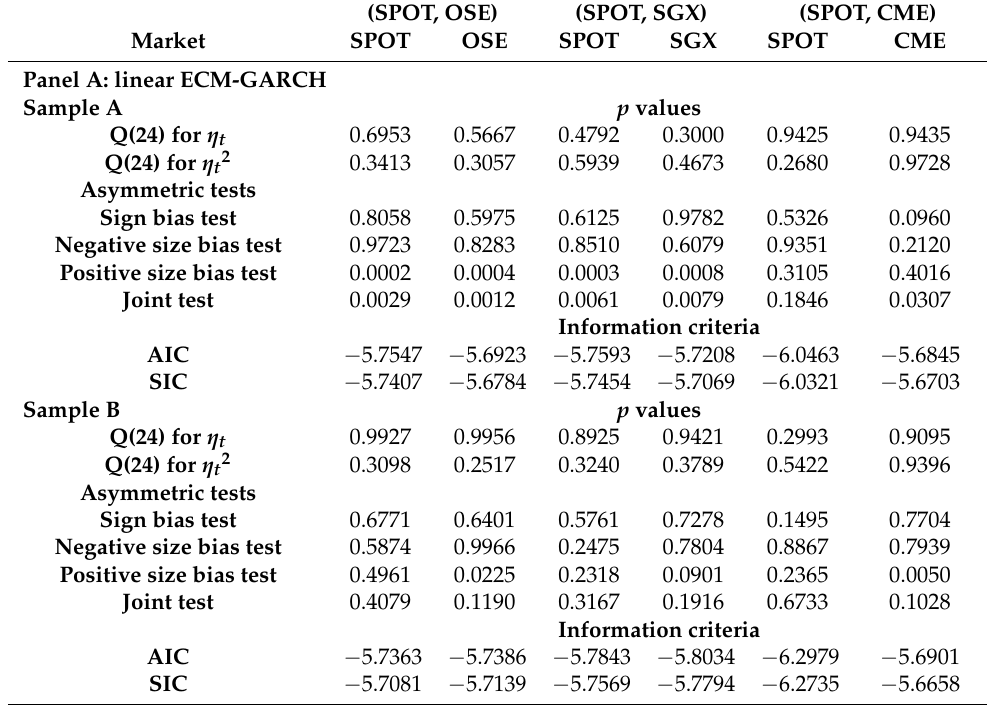
Table A3. Model evaluation for spot–futures